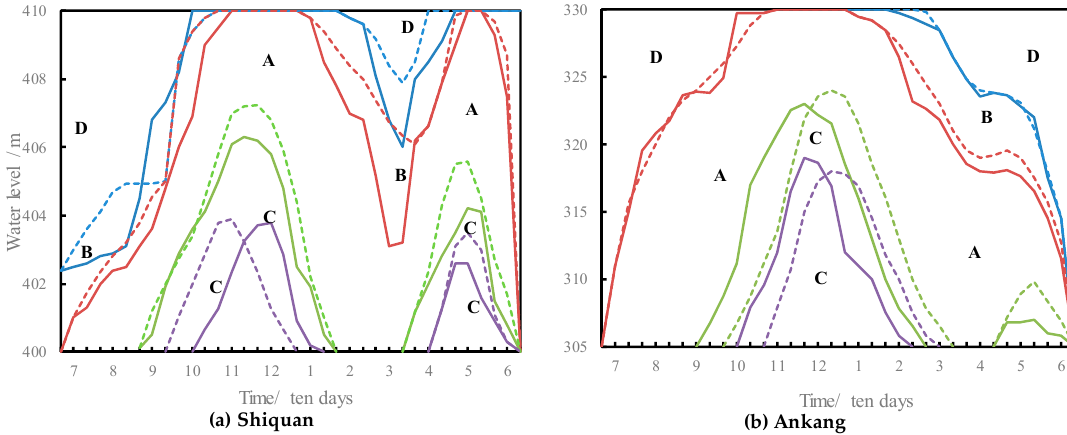
Figure 6. Modified hydropower operation charts for Shiquan (a) and Ankang (b) to address the effects of climate change and human activities. The solid and dashed lines indicate the modified and traditional